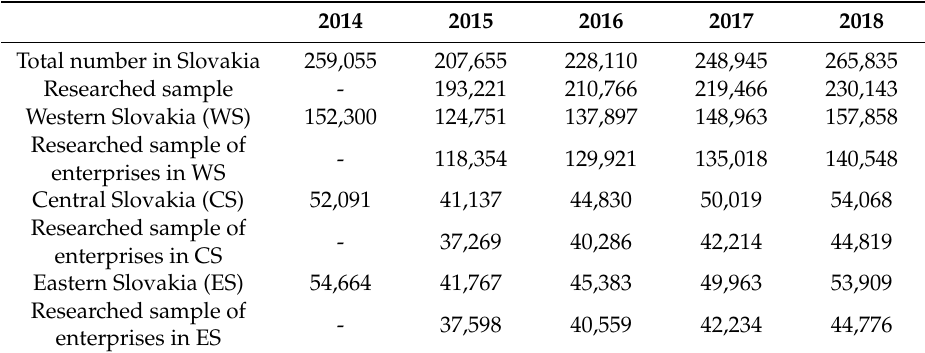
Table 3. Situation of companies in